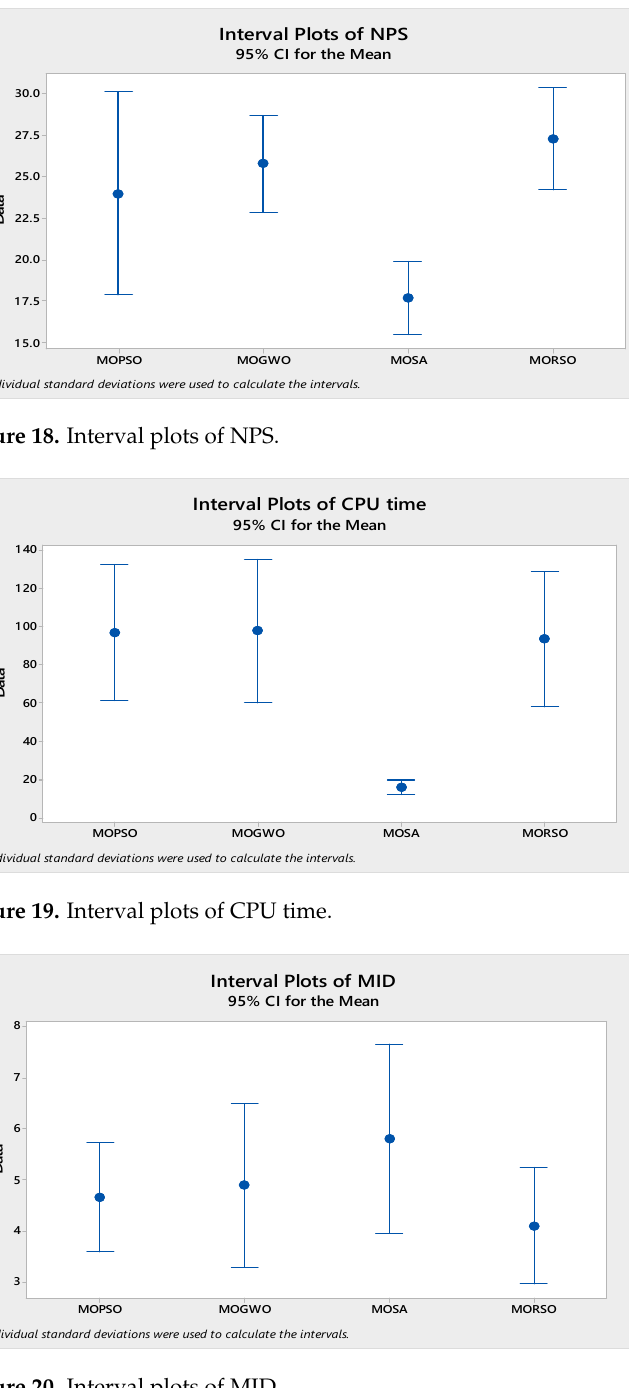
Interval Plots of NPS 95% CI for the Mean